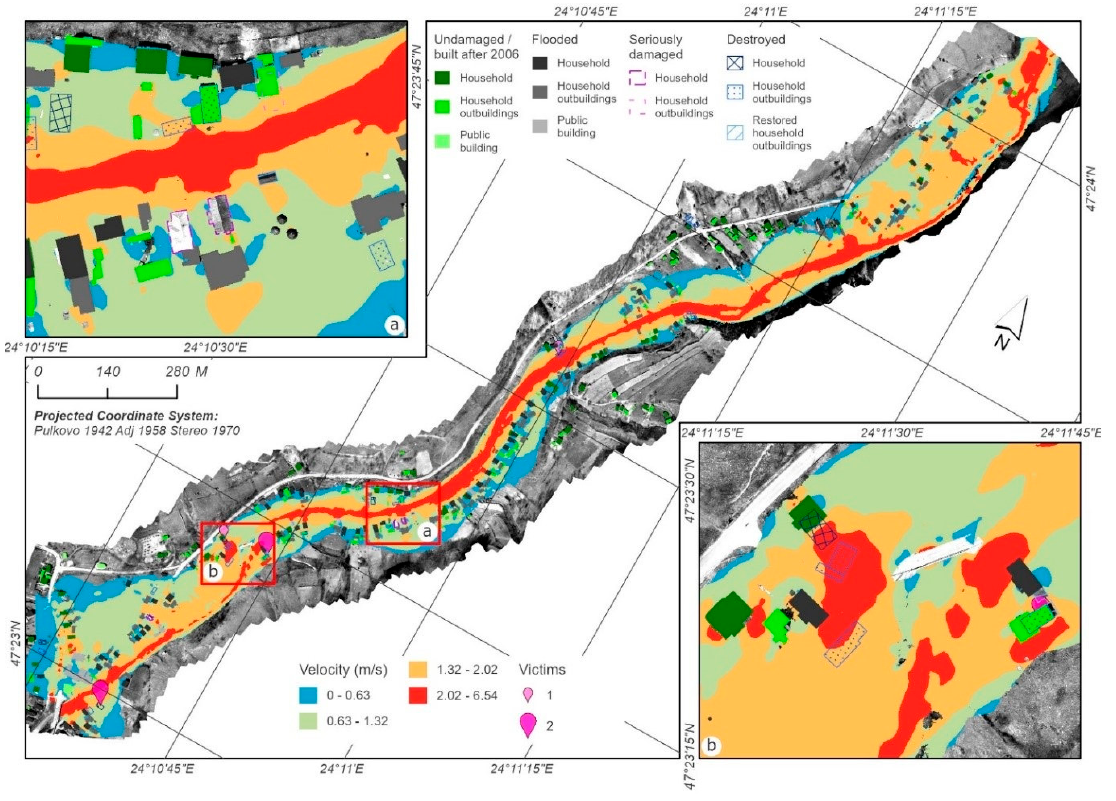
Figure 7. Velocity